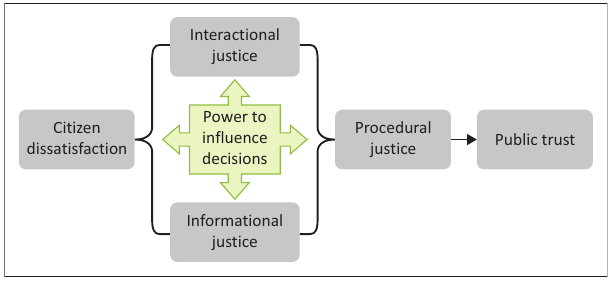
FIGURE 2: Citizen participation–public trust